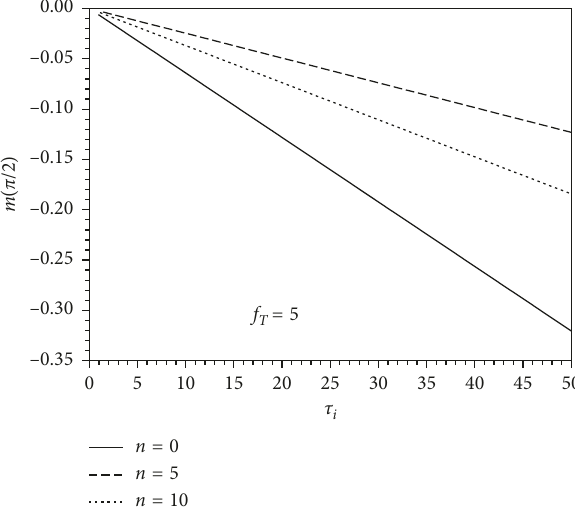
π /2 of the semi- ( )